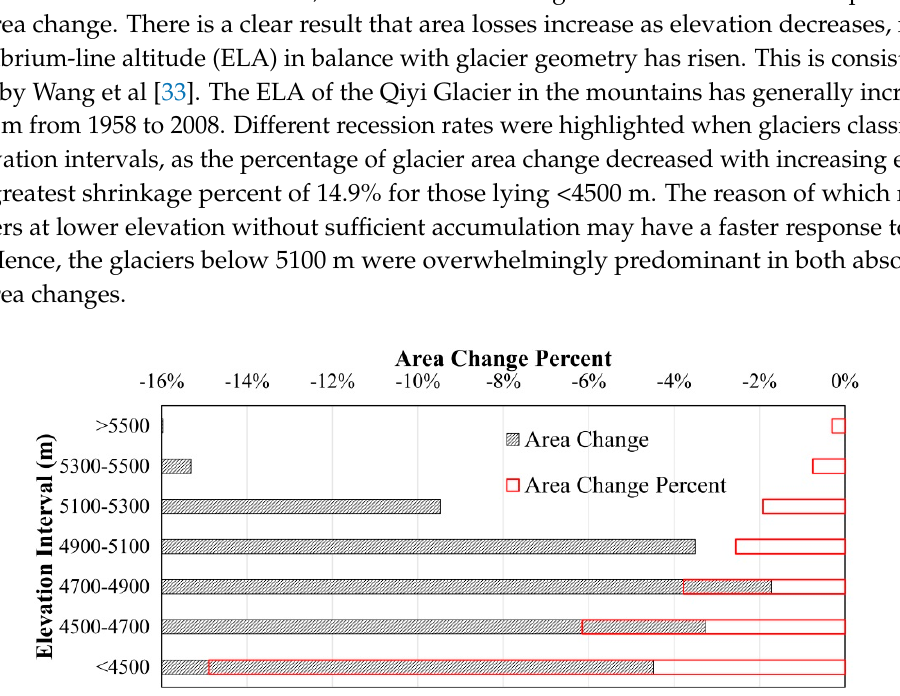
Figure 6. Glacier area proportion in FCGI and area changes with longitude from 1960s to 2015.